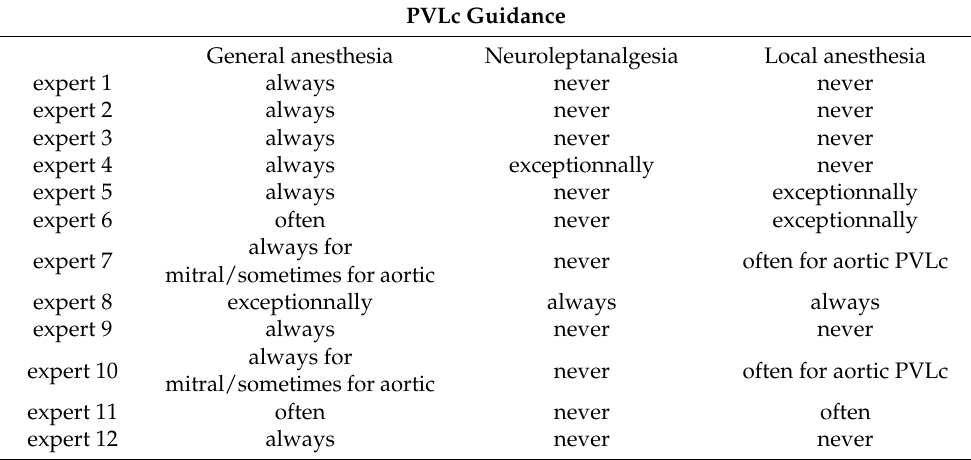
Table 2. The anaesthesia techniques for percutaneous paravalvular leak closure (tPVLc). PVLc Guidance General anesthesia Neuroleptanalgesia Local